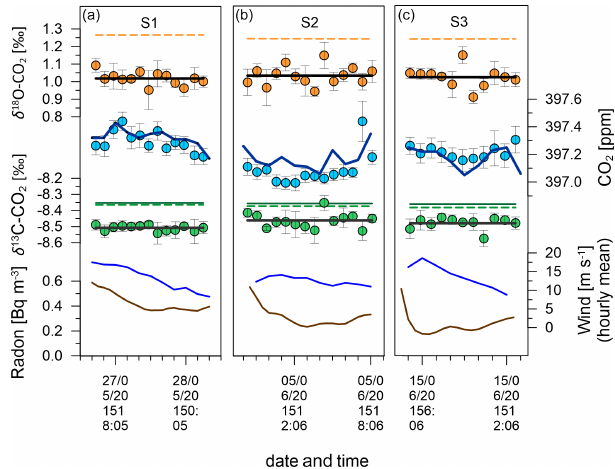
Figure 16. Data from southerly events S1 (a) , S2 (b) and S3 (c) . Radon is shown in brown lines and mean hourly wind speed in blue lines. Green, blue and orange filled circles show average Delta Ray values for δ 13 C-CO 2 , CO 2 mole fractions and δ 18 O-CO 2 , respec- tively. Error bars indicating the standard deviation (1 σ ). Flat black lines indicate the event averages of the Delta Ray values for δ 13 C- CO 2 and δ 18 O-CO 2 . The dark green line shows the interpolated δ 13 C-CO 2 value measured in flask samples before and after the test campaign, while dashed lines represent the interpolated values from δ 13 C-CO 2 and δ 18 O-CO 2 observations at Cape Grim Observatory. The dark blue line shows the CO 2 mole fraction values as interpo- lated from 5min averages of the Siemens analyser at